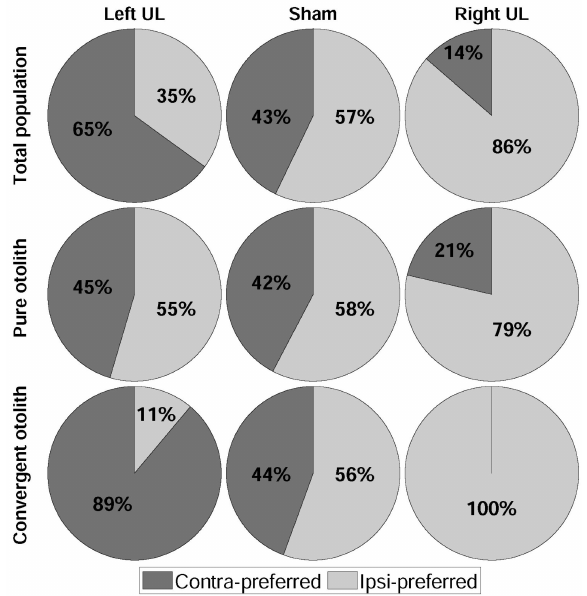
Figure 4. Population by lesion location. Total population in 1st row; purely otolith-related in 2nd row; otolith- and canal-related vestibular units in 3rd row.